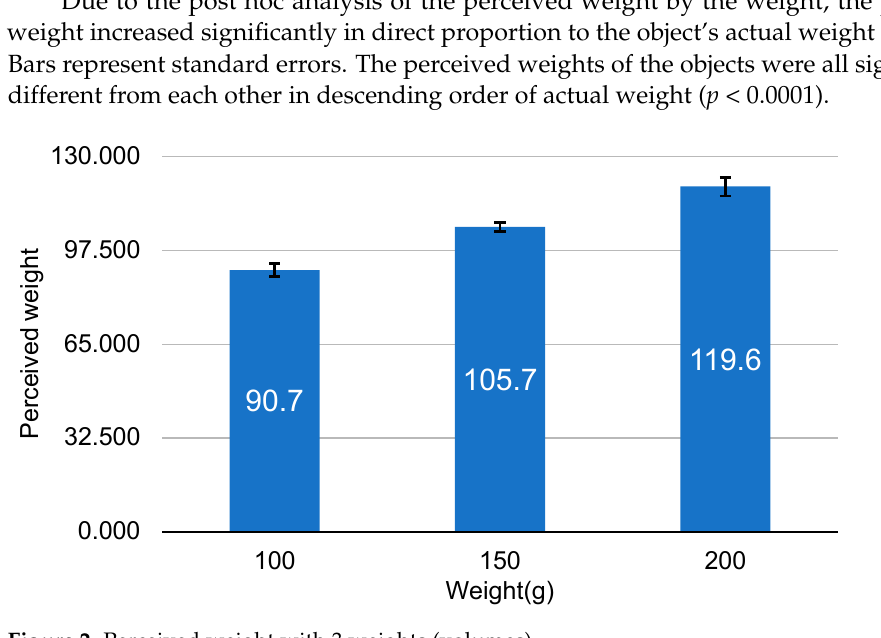
Figure 2. Perceived weight with 3 weights (volumes).